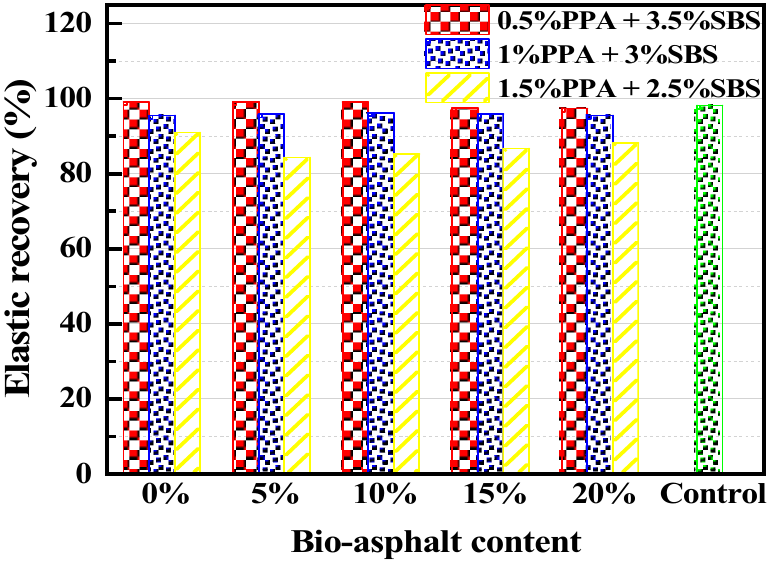
Figure 6. Test results for elastic recovery.